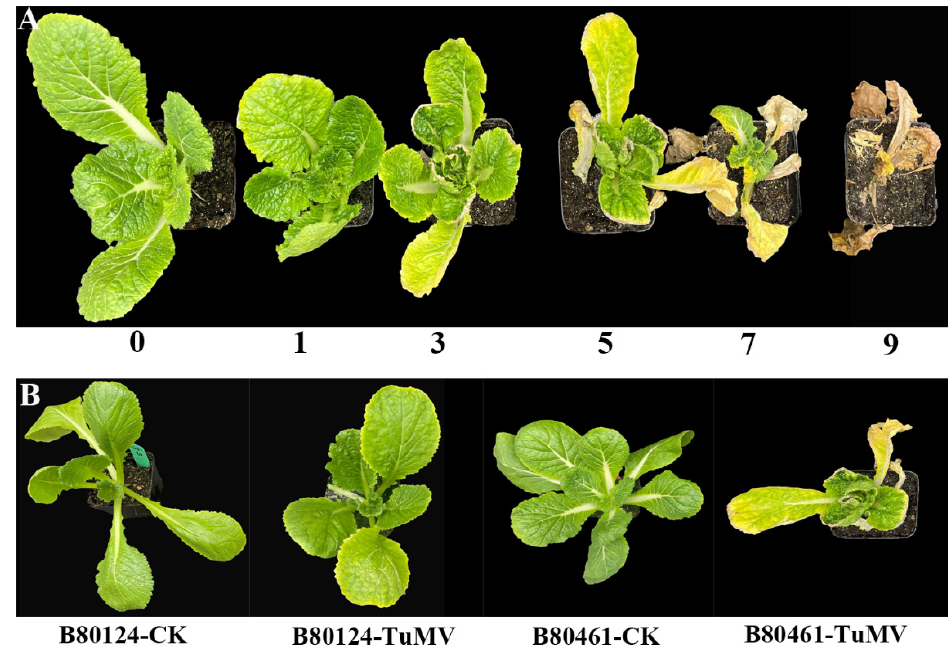
Figure 1. Ranks of turnip mosaic virus (TuMV) in brassica crops. From the phenotype analysis, the resistant index was divided into six ranks, i.e., 0, 1, 3, 5, 7, and 9 ( A ), B80124-CK and B80461-CK were the blank group (not inoculated with TuMV), and B80124-TuMV and B80461-TuMV were the experimental materials (inoculated with TuMV) ( B ).